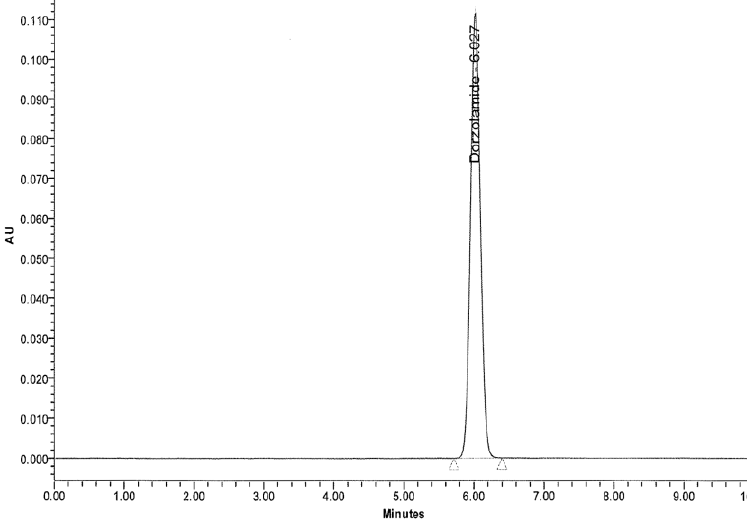
Figure 2 . A typical chromatogram of Dorzolamide by RP- HPLC.